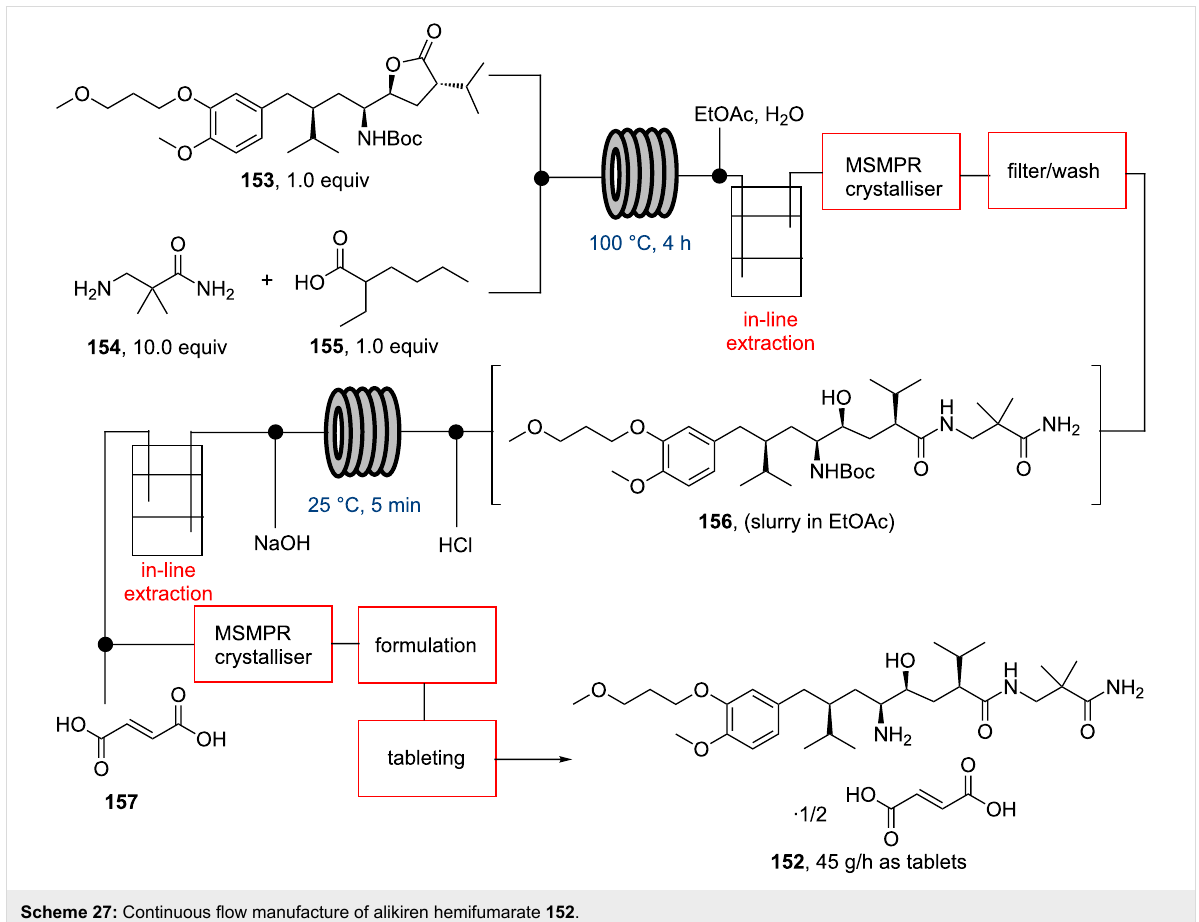
Scheme 27: Continuous flow manufacture of alikiren hemifumarate 152